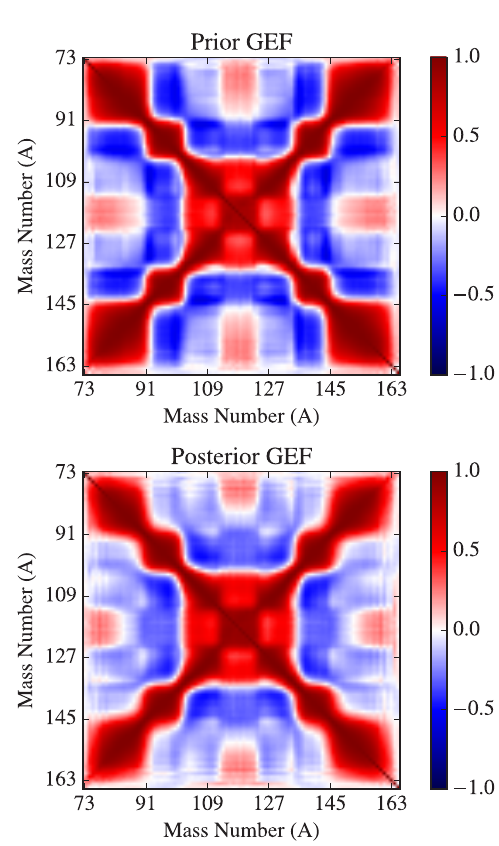
Figure 4. Correlations matrices of independent FYs of